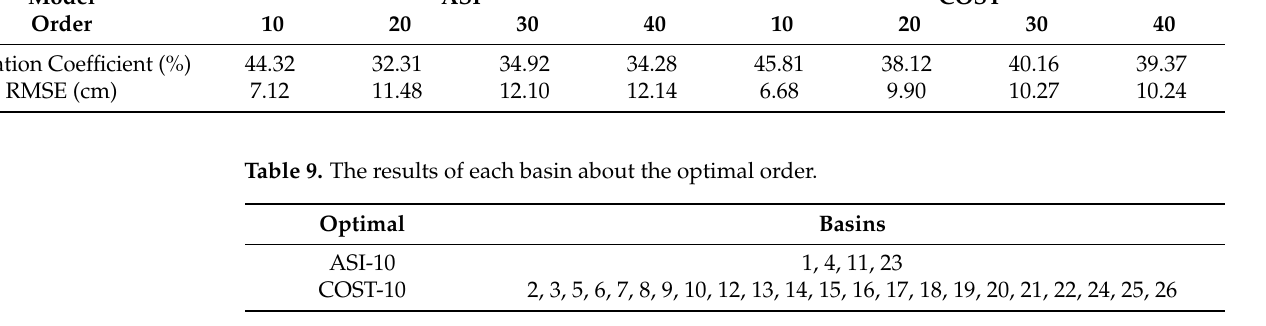
Table 8. The average results of Swarm-TWSC of different order compared with GRACE-TWSC in 26 basins. Model ASI COST Order Correlation Coefficient (%) 44.32